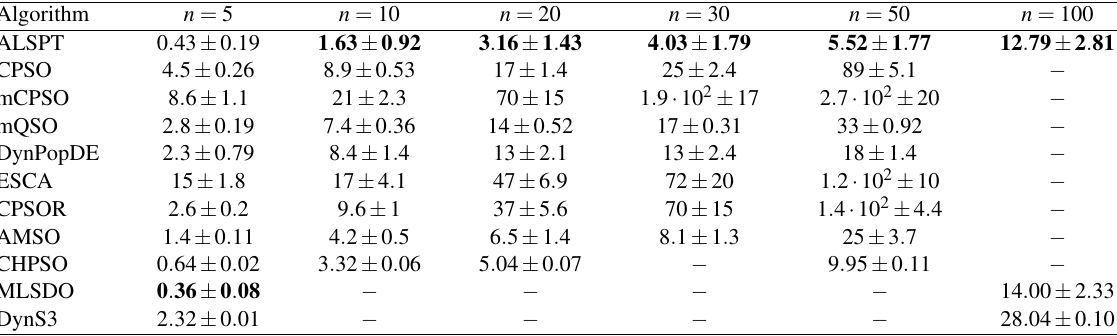
Table 10. e of f and standard deviation obtained by our proposal (ALSPT) and the considered state- of-the-art algorithms in the MPB with different dimensions ( n = { 5 , 10 , 20 , 30 , 50 , 100